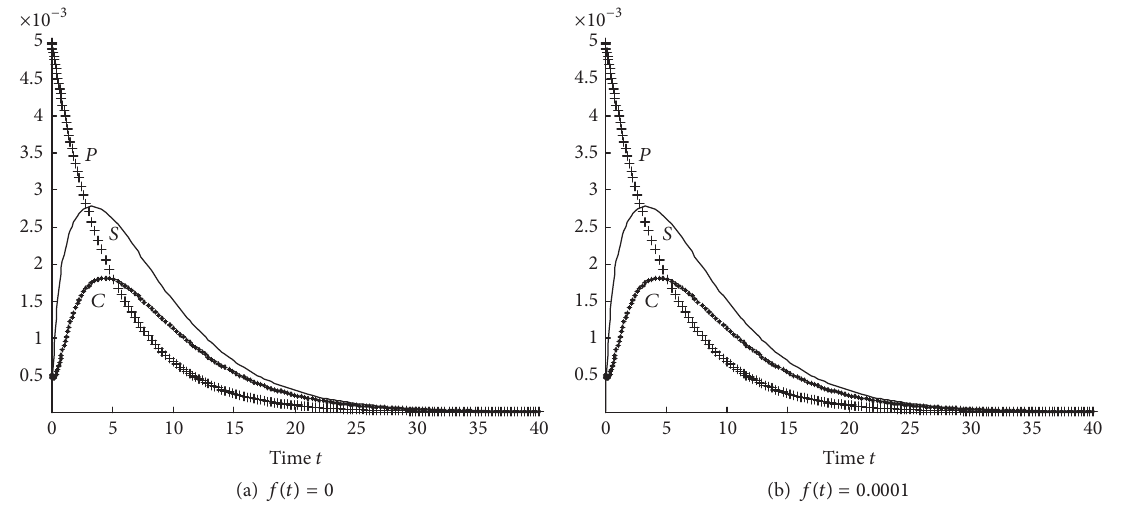
Figure 4: Variation trends of parameters and resource elements under system instability (when 𝛽 3 − 𝜃 2 + √(𝜃 2 + 𝛽 3 ) 2 + 4𝛼 3 𝛽 2 > 0